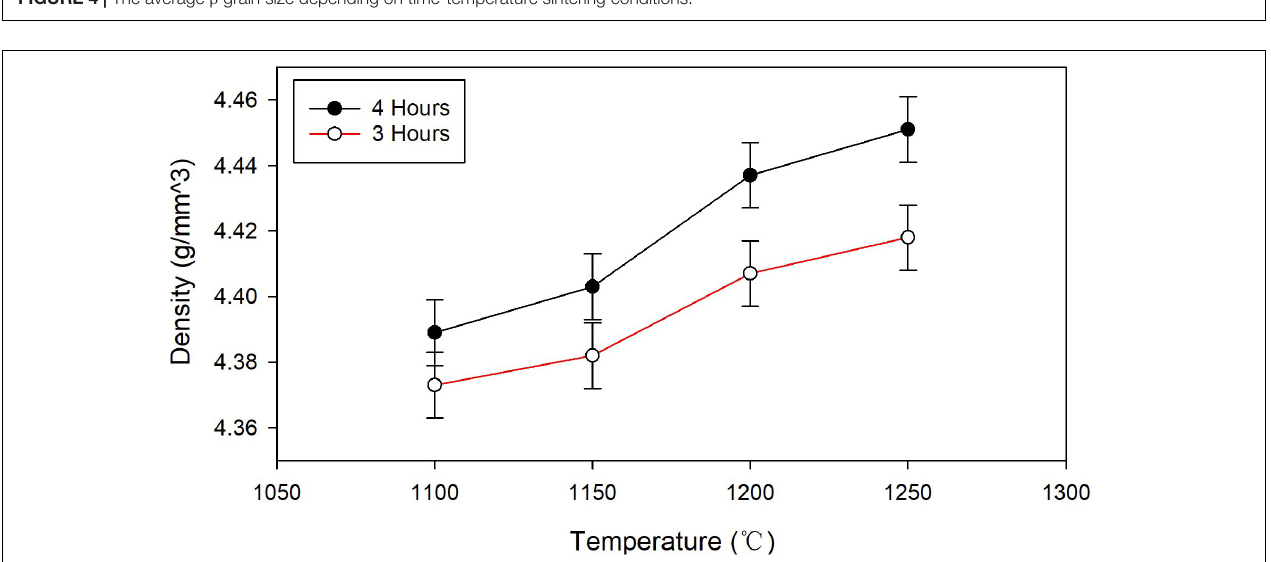
FIGURE 4 | The average β grain size depending on time-temperature sintering conditions.